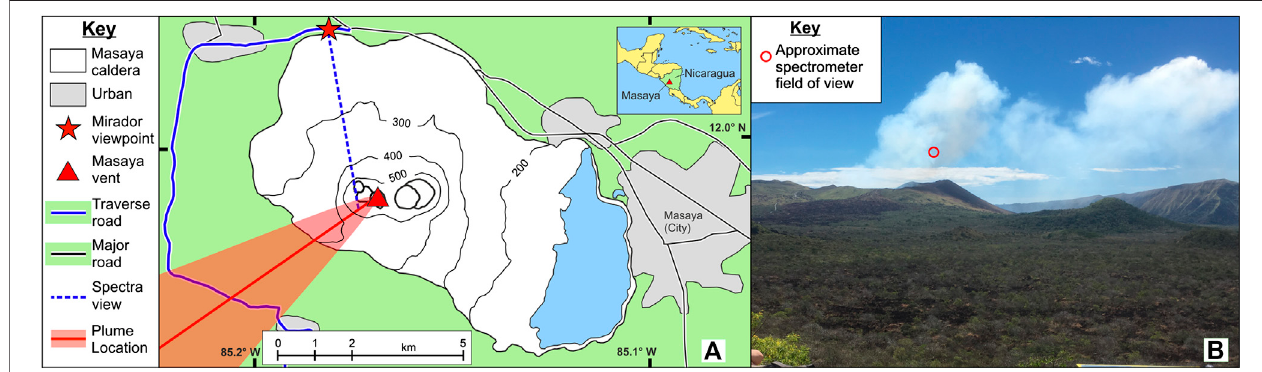
FIGURE 2 | (A) Map of Masaya crater with important measurement locations marked. Traverses were conducted along the Ticuantepe road to the West of the volcano (blue line) and a fi xed spectrometer was deployed at the Mirador viewpoint. The plume direction (red line) shown is the average location along the road of the plume center of mass (inset shows the location of Masaya volcano within Nicaragua). (B) shows a photograph taken from the Mirador viewpoint with the approximate spectrometer fi eld of view marked.